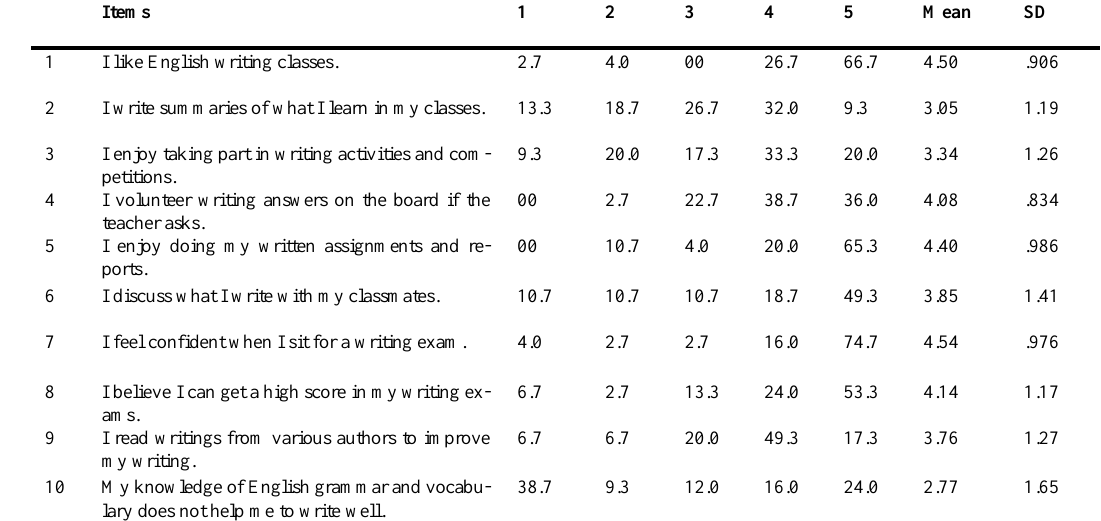
Table 2. Attitudes toward writing in English (school